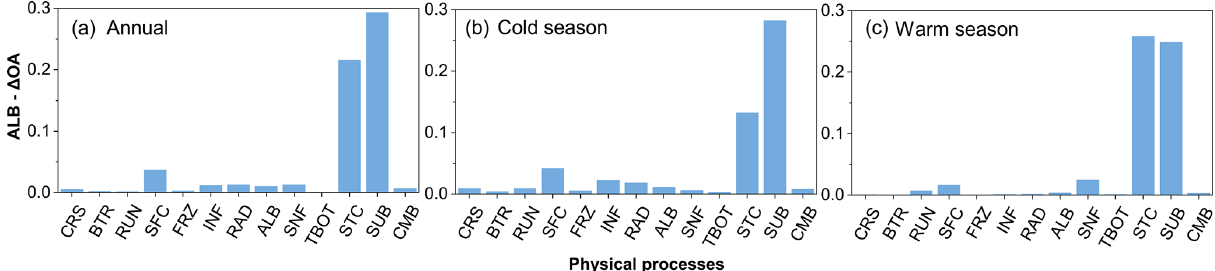
Figure 4. The maximum difference in the mean overall accuracy (OA) for albedo (ALB- (cid:49) OA) in each physical process (a) annually and during the (b) cold and (c) warm seasons at the TGL site.